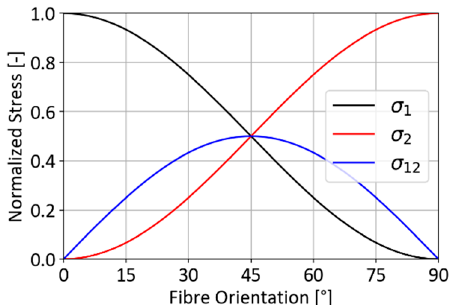
Figure 3. Normalized variation of local stress components after application of pure tensile load on a